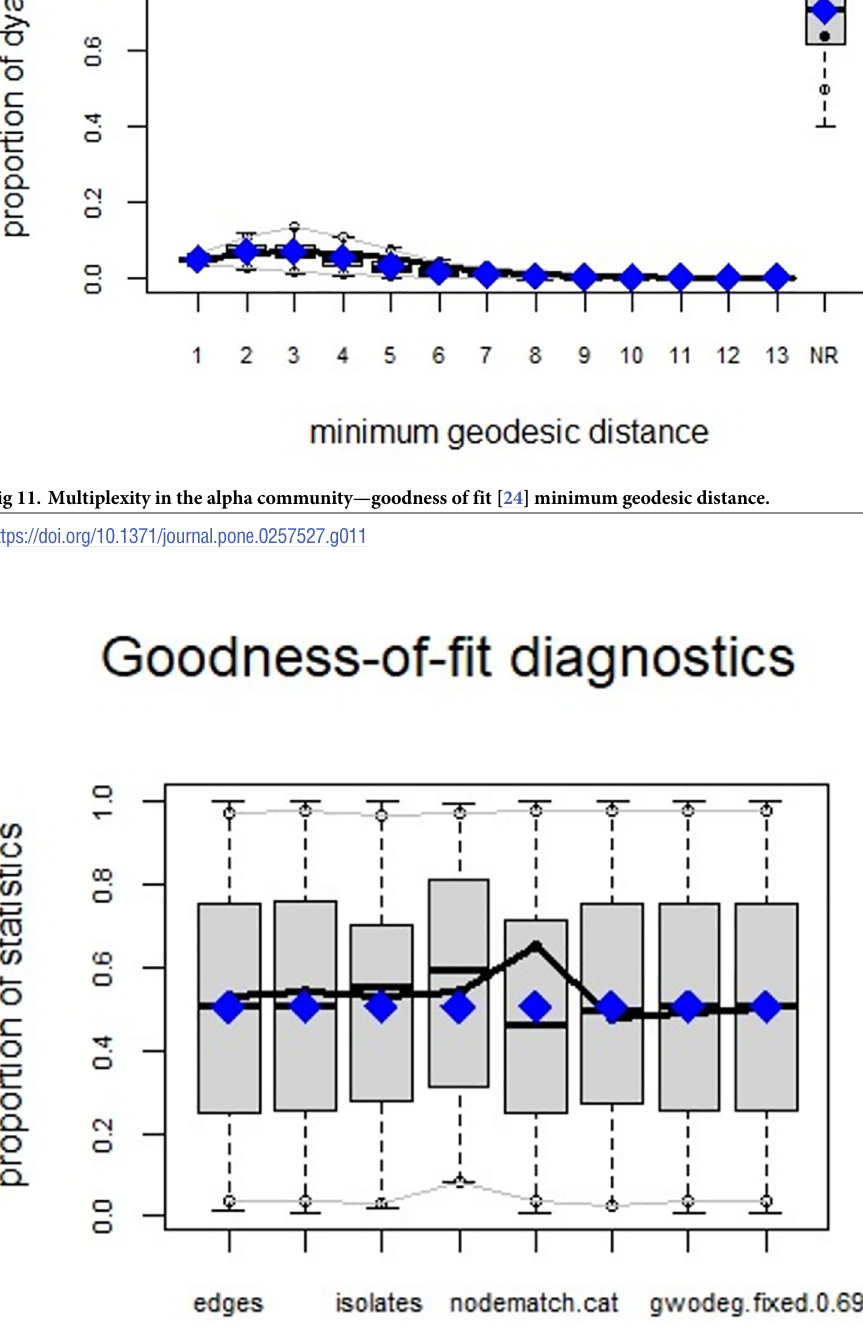
PLOS ONE | https://doi.org/10.1371/journal.pone.0257527 September 27,